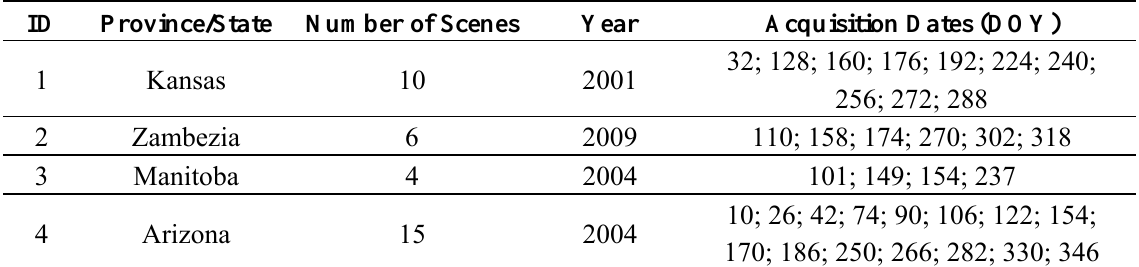
Table 2. Acquisition dates of Landsat imagery for each study